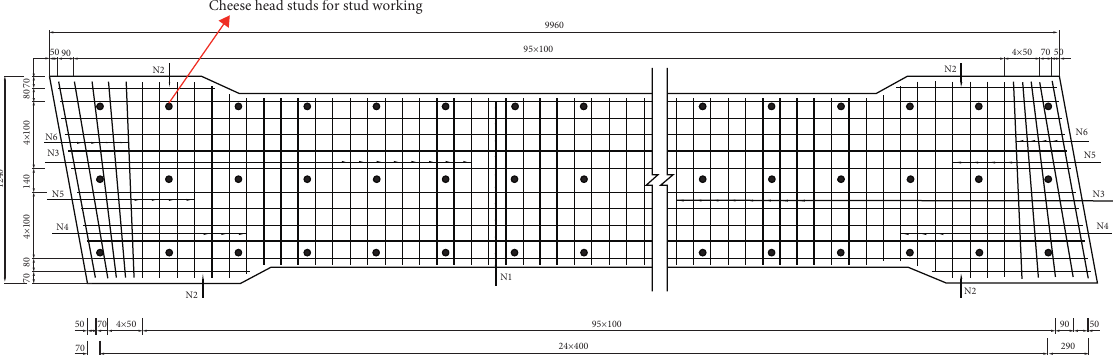
Figure 2: Layout of welding pin position on UHPC